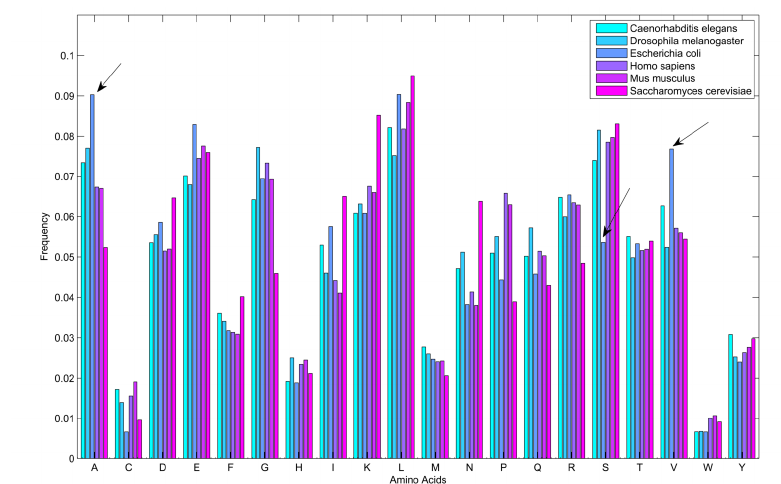
Figure 3. Histogram of the amino acid observing frequencies of lncRNA-binding proteins for six organisms. Escherichia coli has relative higher observing frequencies of amino acids A and V as well as much lower content of amino acid S compared with that of the other five organisms (highlighted by arrows).